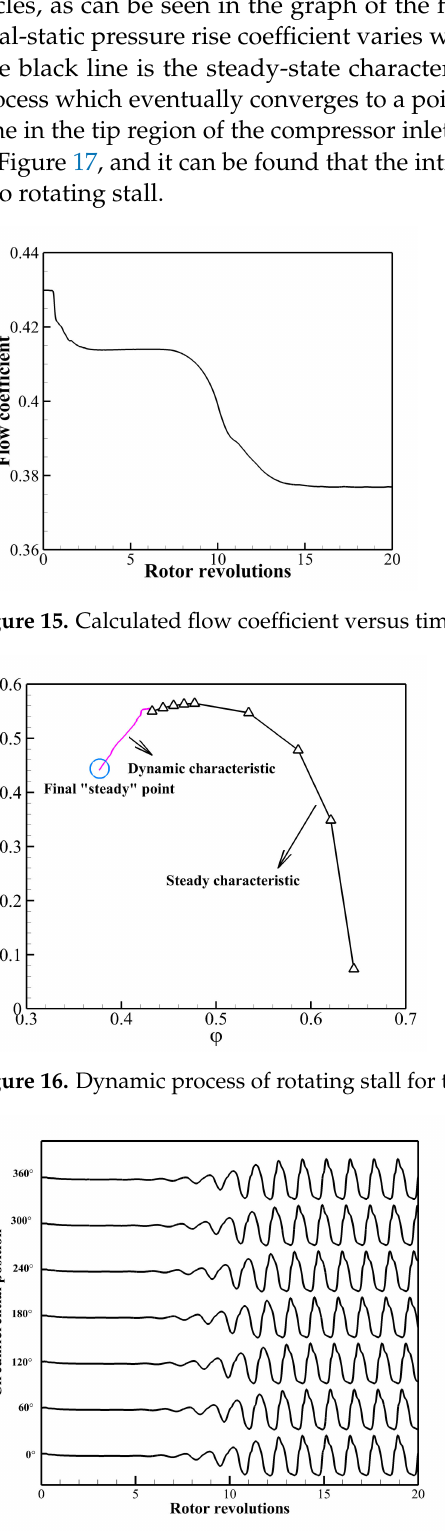
Figure 17. Traces of axial velocity in the tip region of compressor inlet at different circumferen- tial